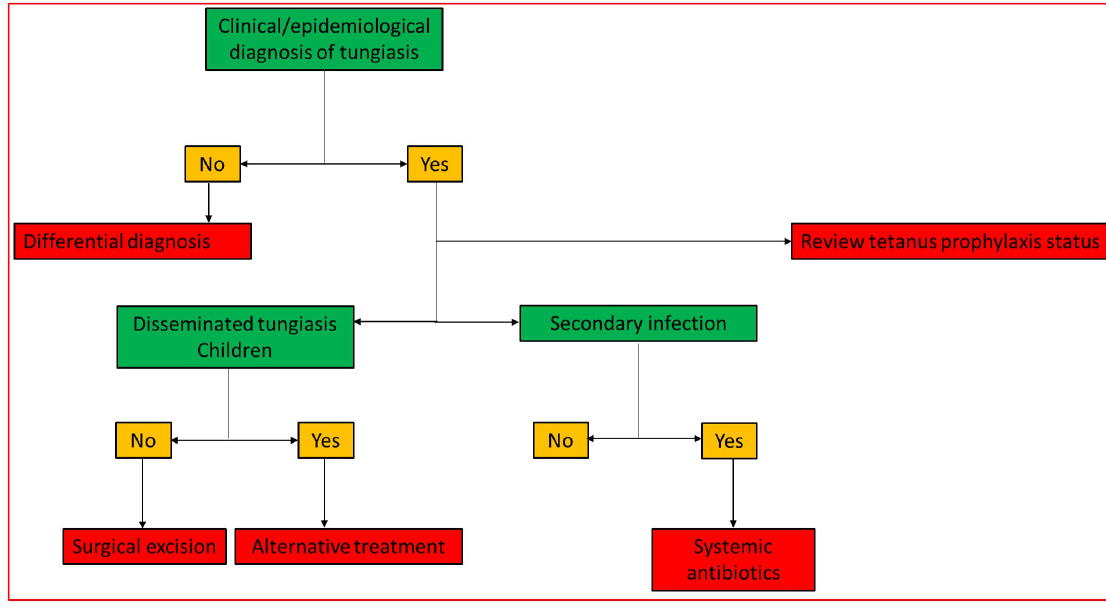
Fig 1. Current clinical pathway proposed for the treatment of